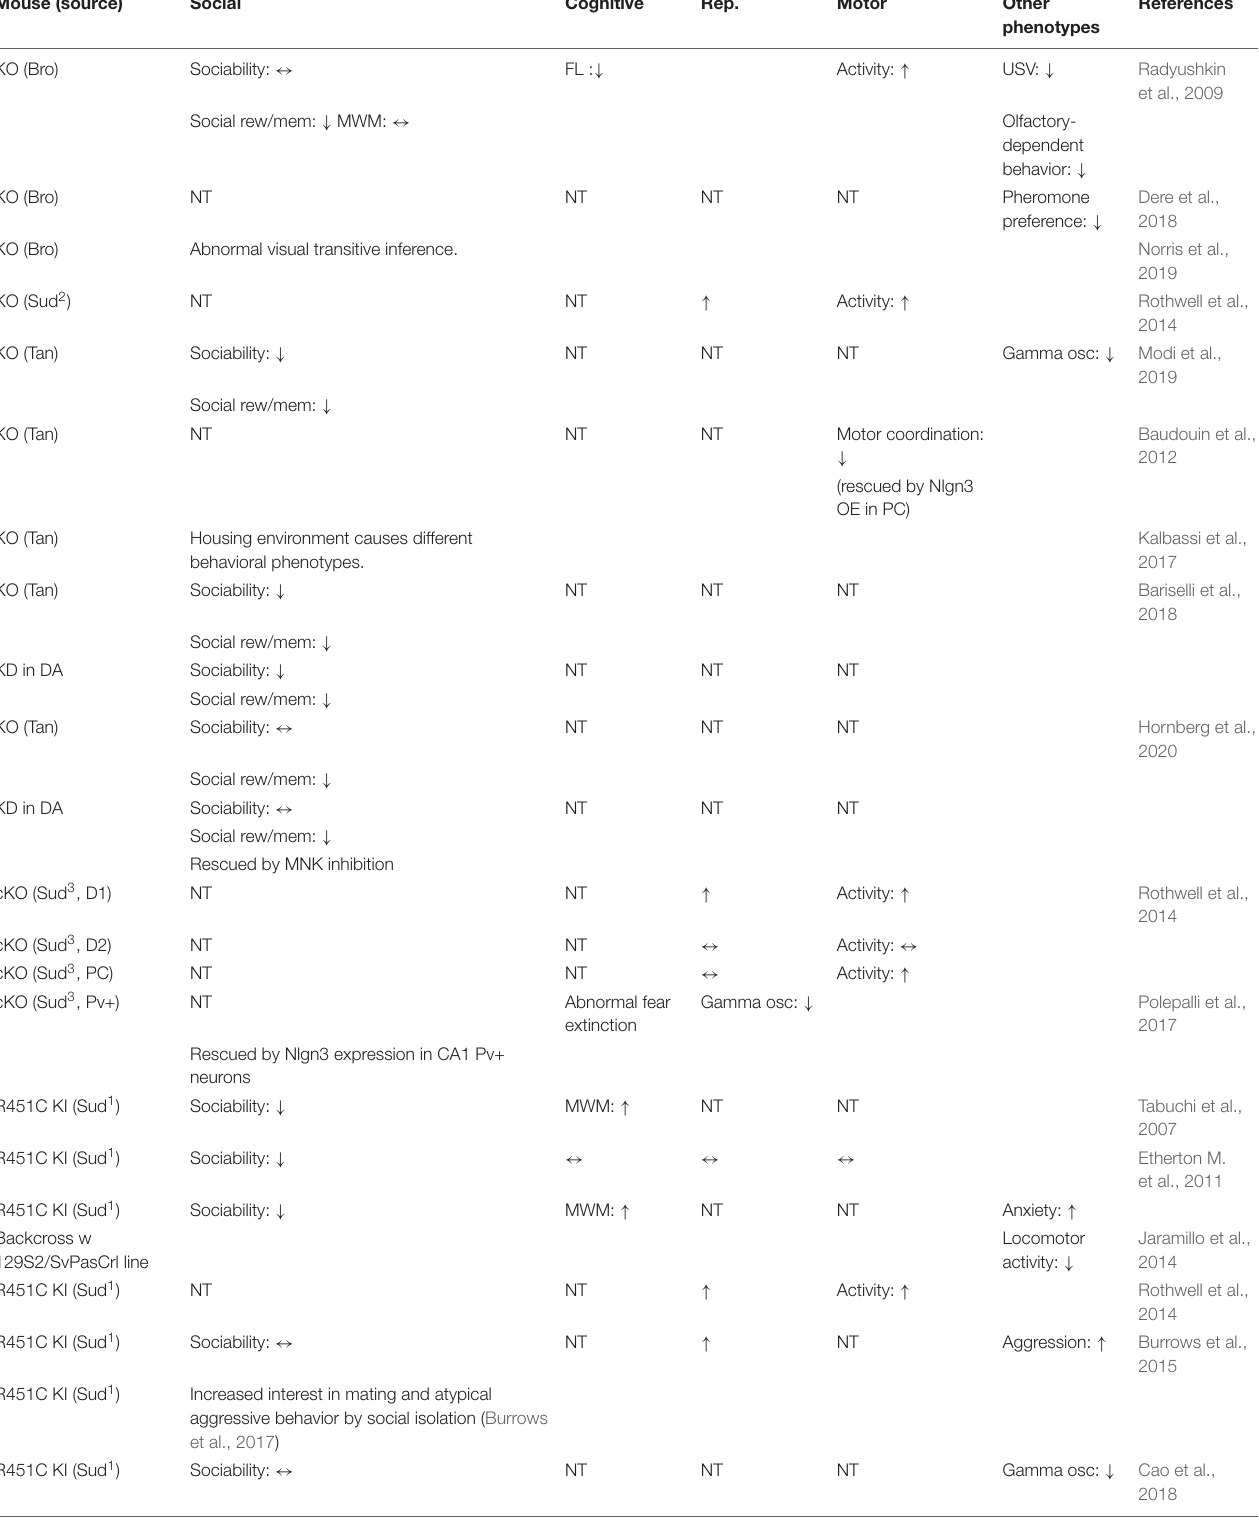
TABLE 3 | Summary of behavioral tests in Nlgn3 mutant mouse lines. Mouse (source) Social Cognitive